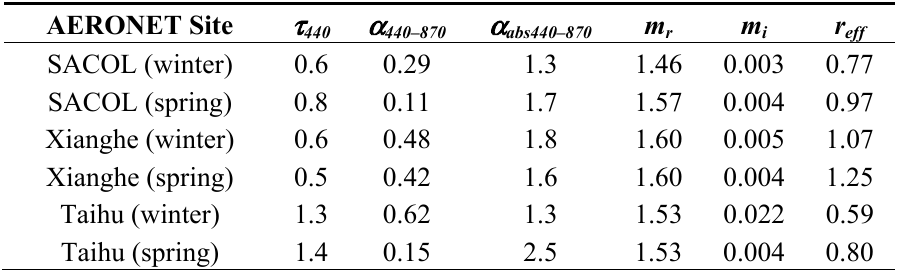
Table 1. Summary of the AERONET retrieved aerosol optical properties for the winter and spring cases.